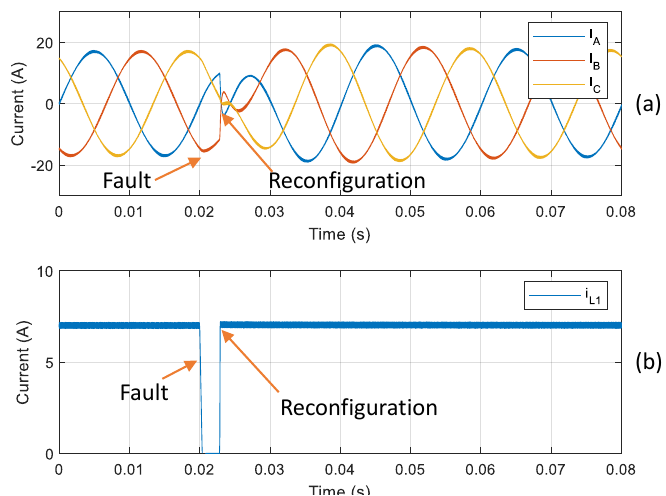
Figure 5. Simulation of an open-circuit fault on switch S pv1 . ( a ) grid currents. ( b ) PV1